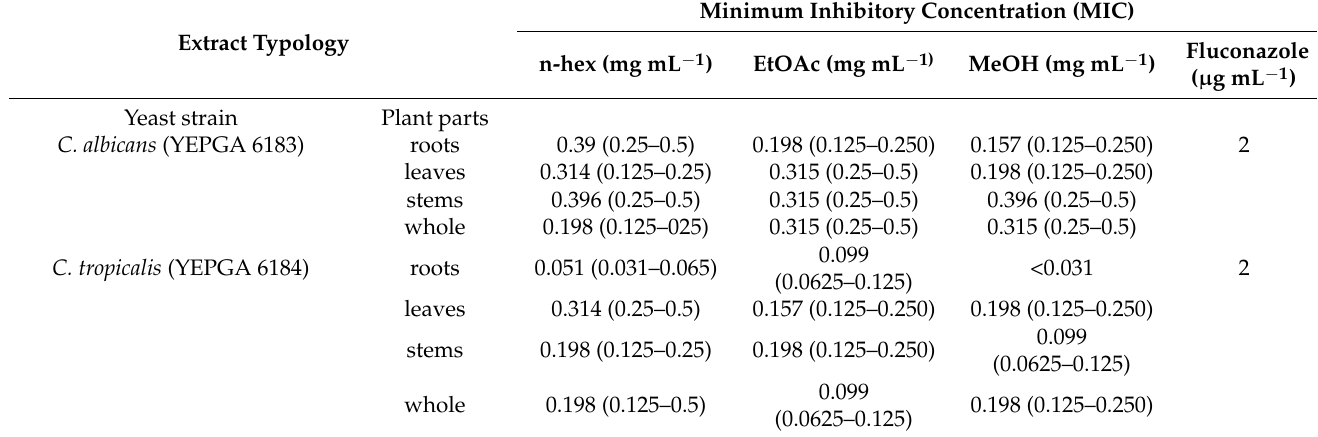
Table 4. Minimal inhibitory concentrations (MICs) of B. pilosa n-hexane, ethyl acetate and methanol extracts and fluconazole against clinical